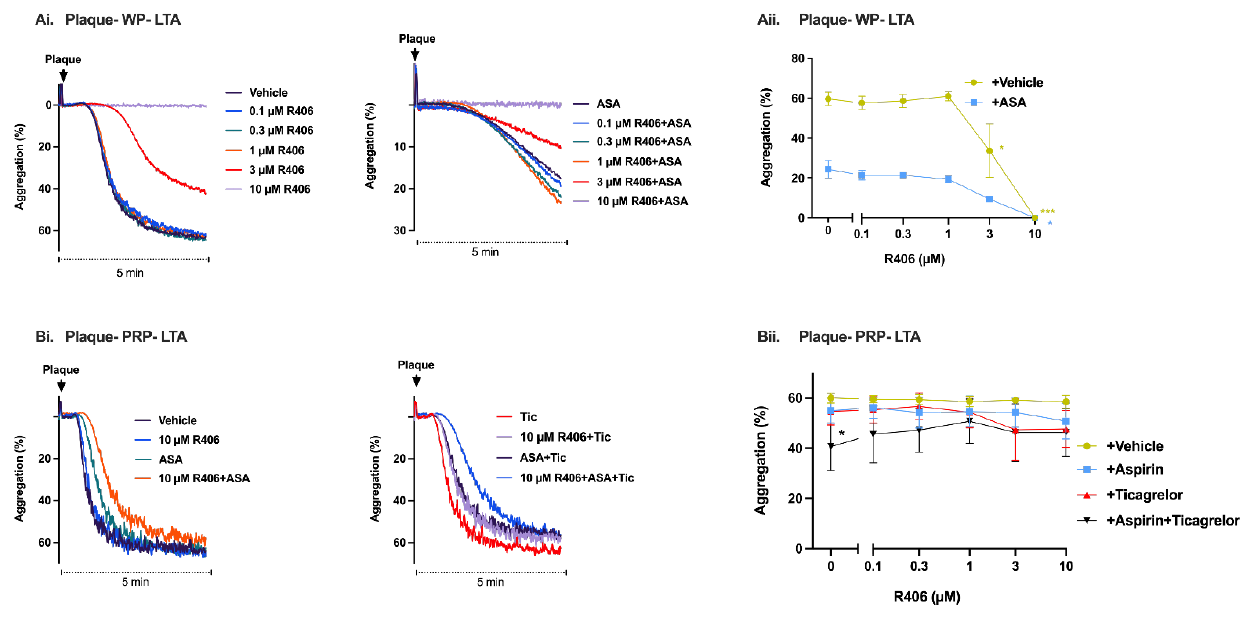
Figure 3. R406 inhibited atherosclerotic plaque-induced platelet aggregation in washed platelets but not PRP or whole blood. Platelet aggregation in healthy donor ( A ) washed platelets ( B ) PRP assessed by light transmission aggregometer (LTA). Samples were incubated with either vehicle, R406, 30 µM of aspirin or 1 µM of ticagrelor for 10 min, then stimulated with 70 µ g/mL of plaque homogenate. Additional representative traces in Supplementary Materials, Figure S4. Results are shown as mean ± SEM of three independent experiments. Results analysed with two-way ANOVA, with Dunnett’s correction for multiple comparisons vs. vehicle control or vs. corresponding comparator (aspirin and/or ticagrelor alone) (* p < 0.05, *** p < 0.001). WP, washed platelets. ASA, aspirin. Tic,